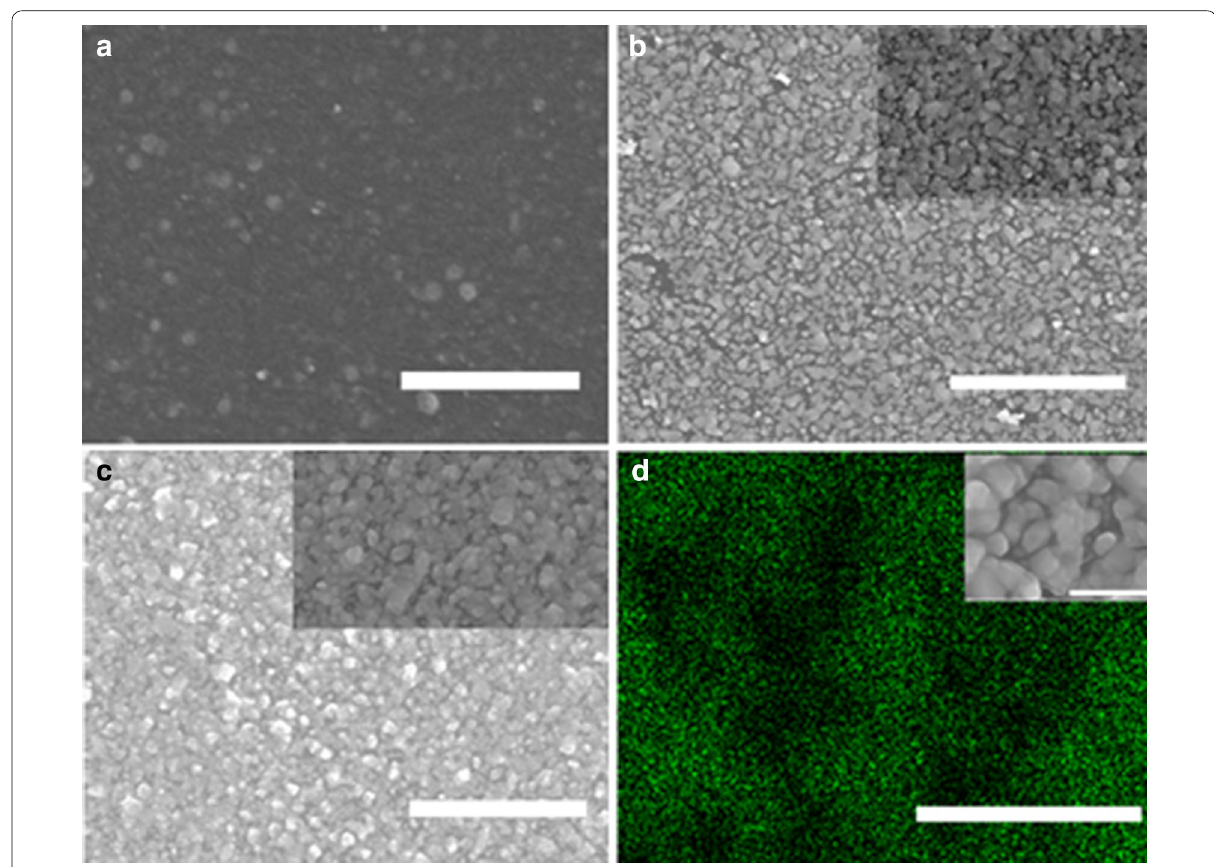
Fig. 6 Electron microscopic analysis of the AgNP-grown PDMS films subjected to various rounds of reactions. From a to c ; one, two and three rounds of reaction, respectively. d Ion mapping image and inset of d corresponding electron microscopic images of AgNP-grown PDMS films after three rounds of the AgNP growing reaction. Insets in b and c are enlarged images of the figures. 500 nm scale bar in each SEM image